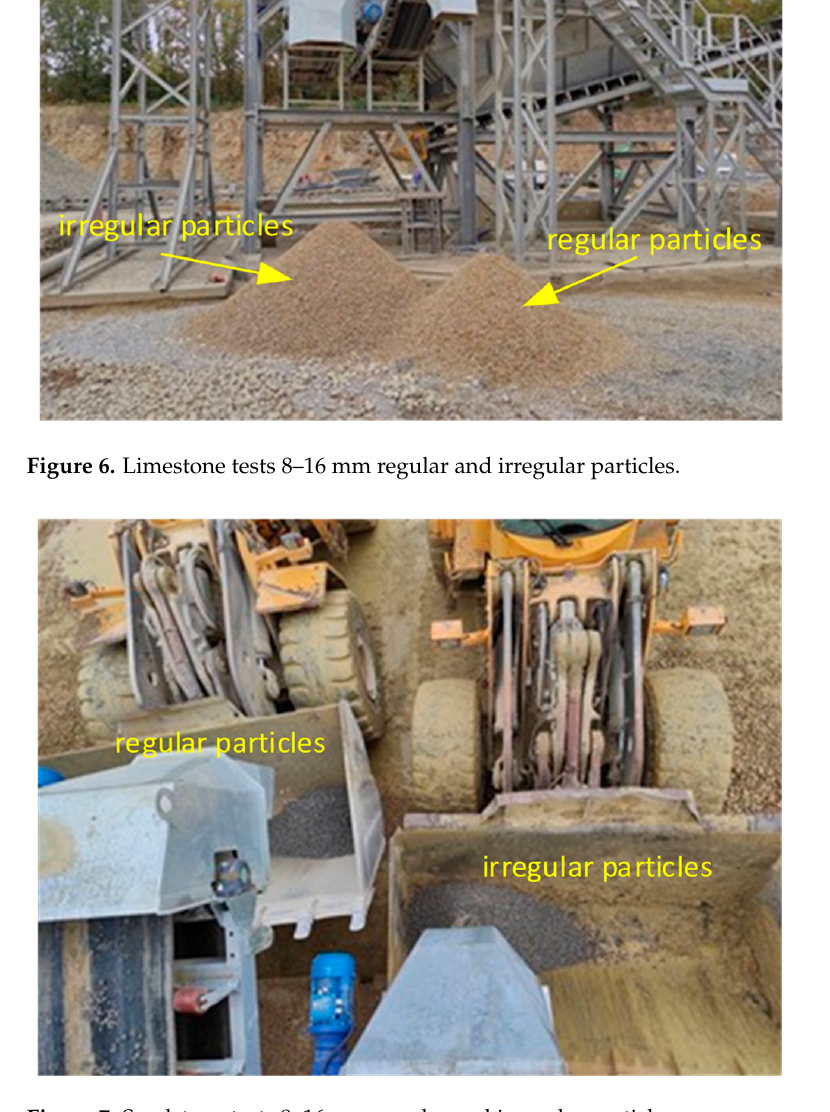
Figure 7. Sandstone tests 8–16 mm regular and irregular particles .